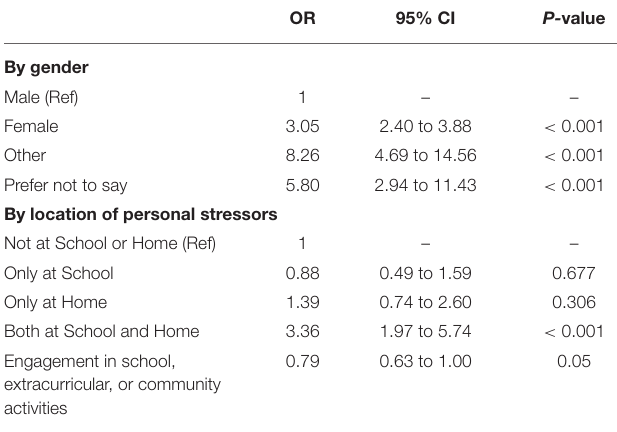
TABLE 2 | Odds ratio for reporting self-harm